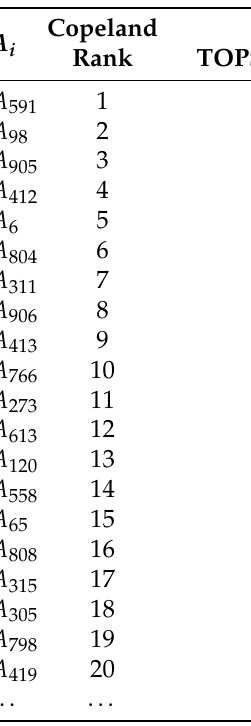
Table 16. Rank values for compromise ranking candidates with consideration of the whole dataset.